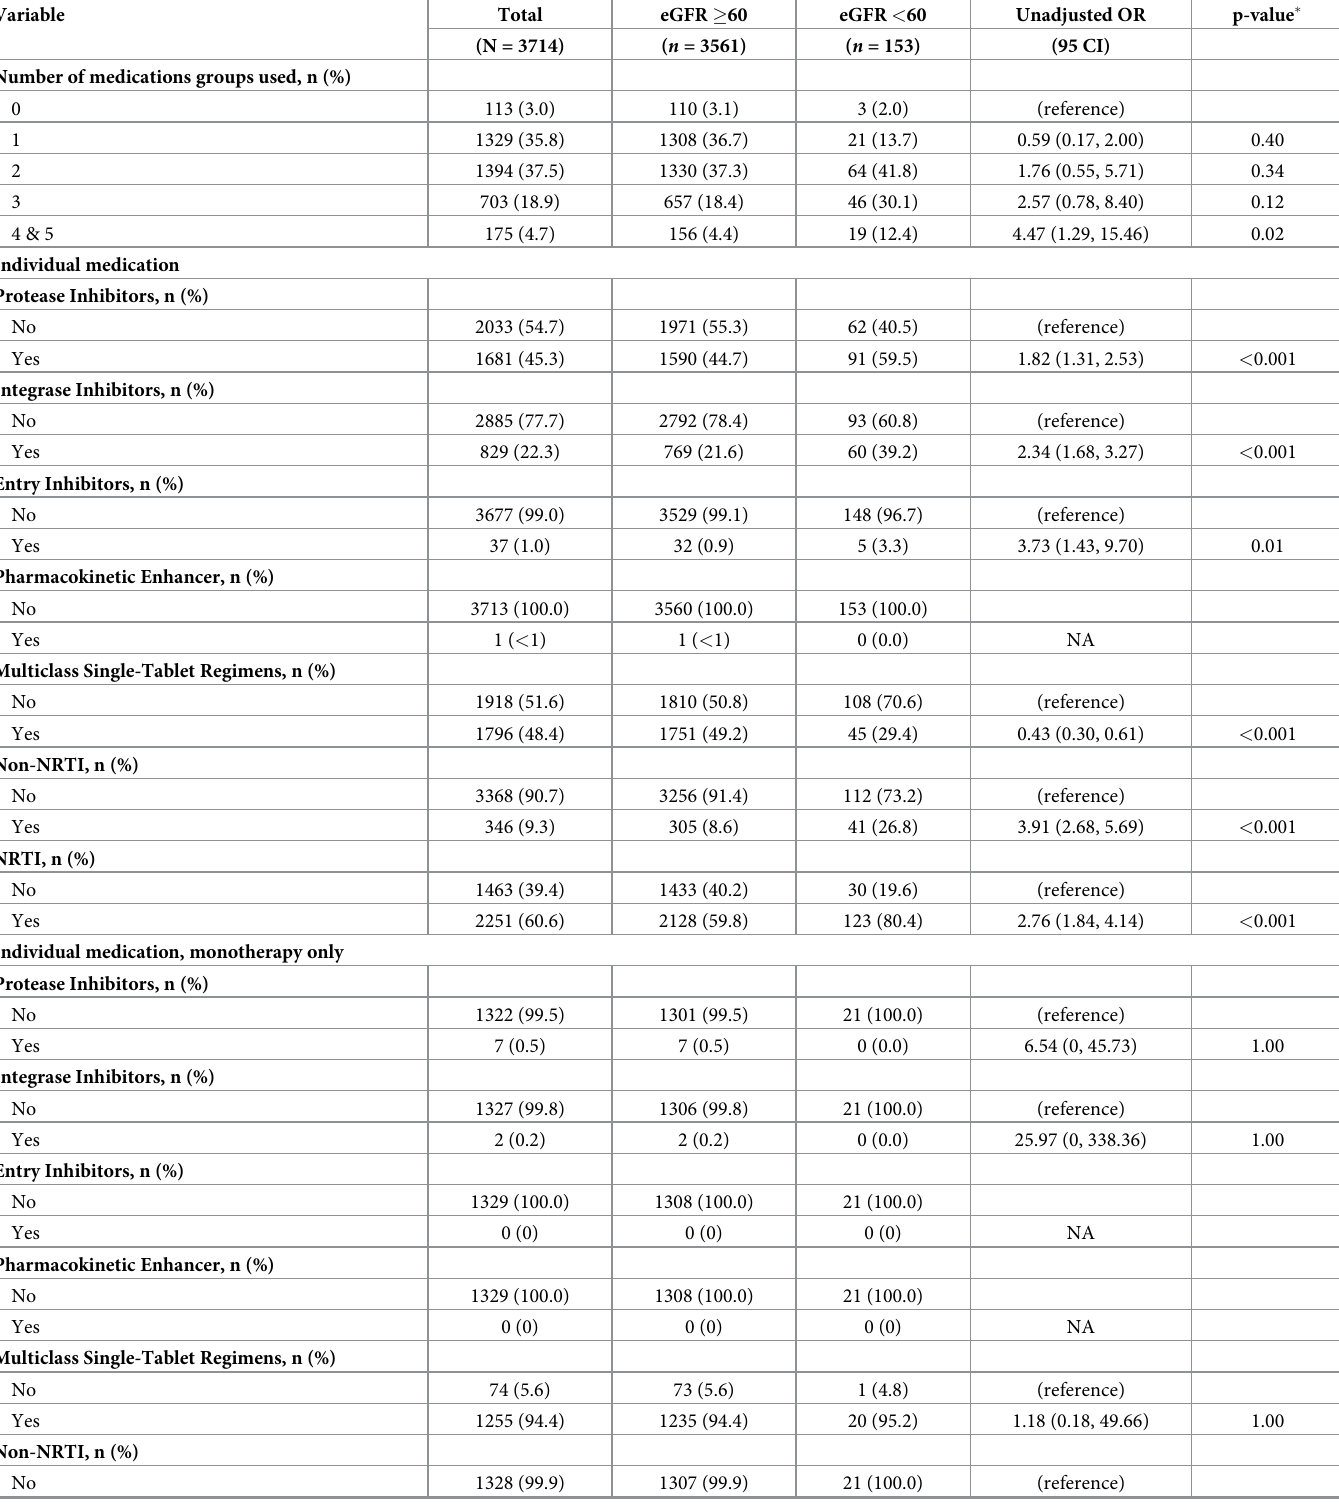
Table 4. HIV antiviral therapy in association with